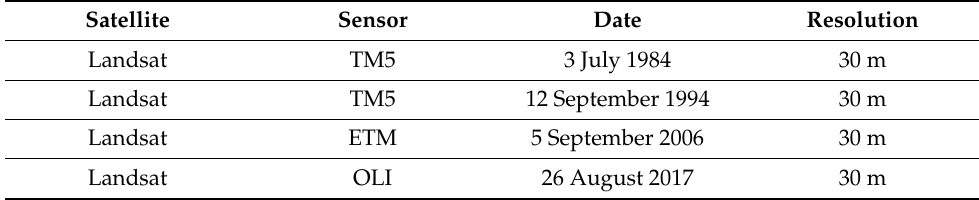
Table 1. Landsat image